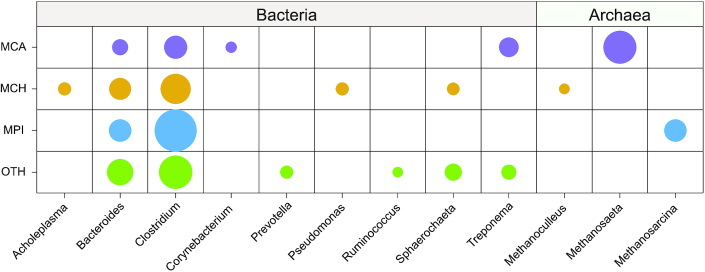
Distributions of feedstock-associated core genera among the 4 groups, MCA, MCH, MPI, and OTH. The area of each circle represents the median value of relative abundance of the corresponding genus in each group, and the non-core genera are not shown. “Core microbes” were defined as the genera most abundantly (top 30 bacterial genera and top 5 archaeal genera) detected in all studied samples. MCA: cattle manure BGPs; MCH: chicken manure BGPs; MPI: pig manure BGPs; OTH: BGPs with other substrates.